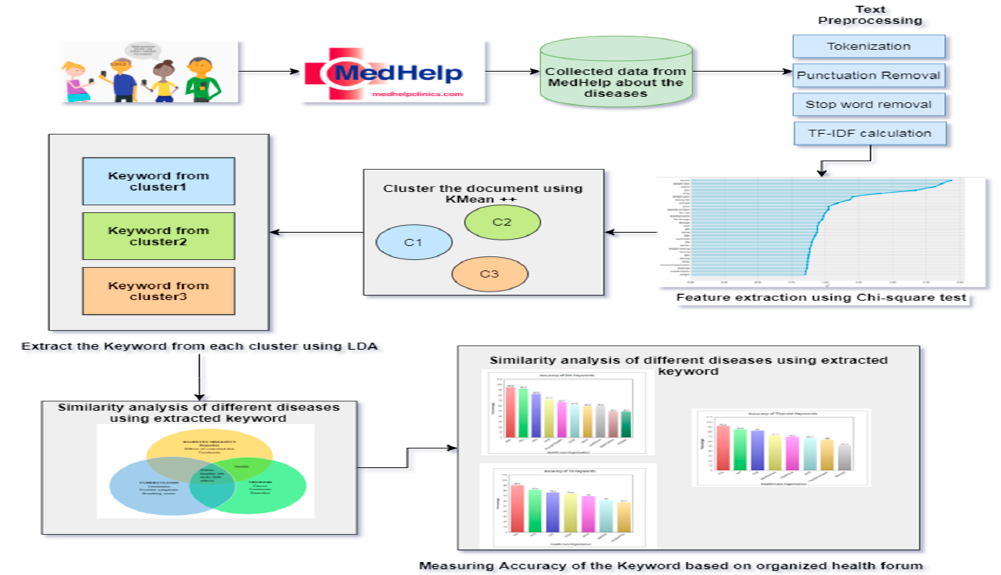
Figure 1. Overall Architecture.